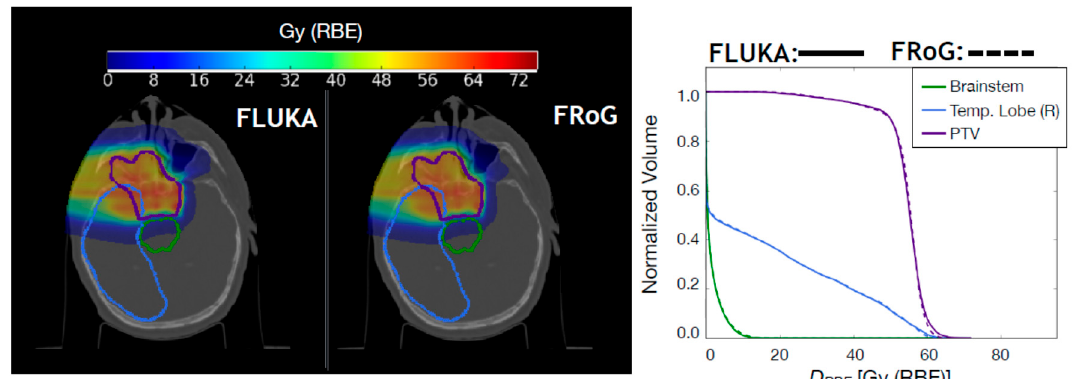
Figure 1. FLUKA and FRoG recalculated D RBE distributions for a proton head case without range shifter (RS) are displayed in the left and middle panel, respectively, together with the contours of three regions of interest: the planning target volume (PTV), brainstem, and right temporal lobe. The D RBE VH for the regions of interest (ROIs) are shown in the right panel.